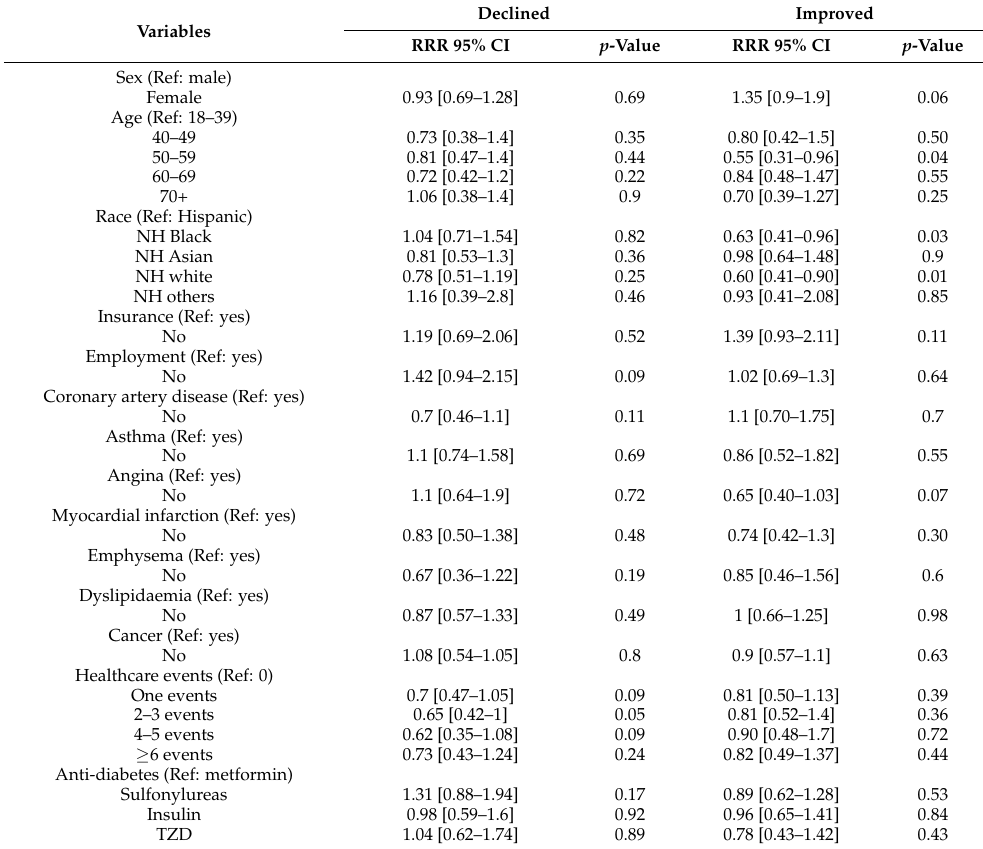
Table 4. Factors affecting physical HRQOL of diabetes